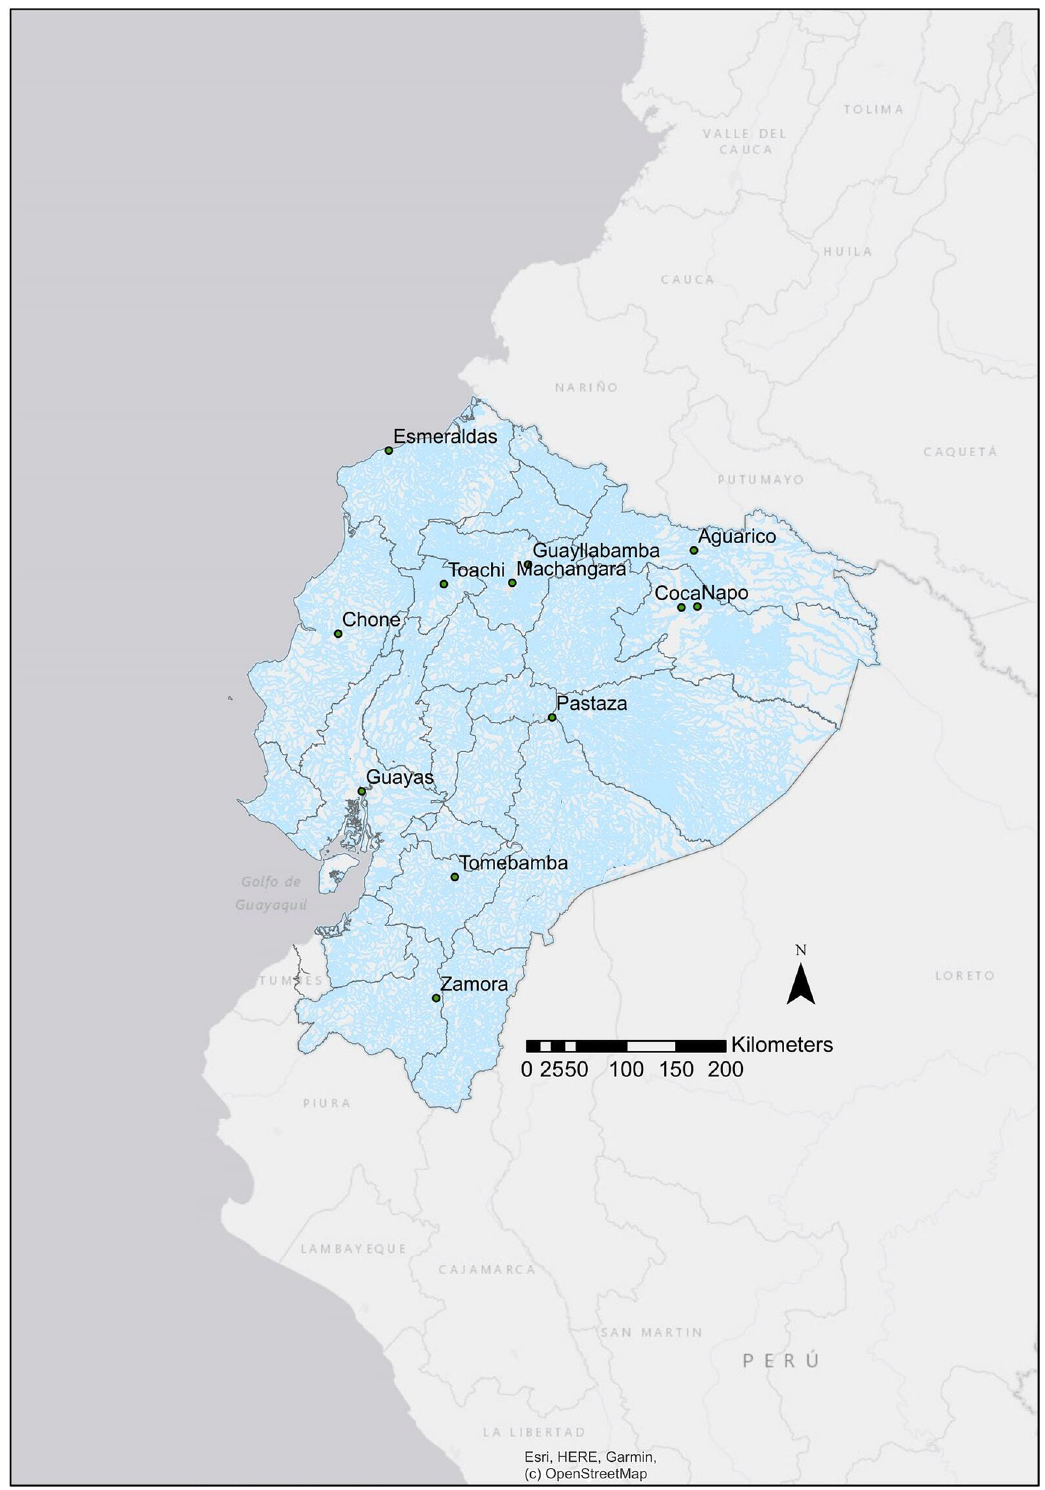
Figure 6. Illustration of the collection sampling points selected in this study for the microbial and chemical evaluation of the main Ecuadorian rivers. Legend: The map of Ecuador with the collection sampling points was created through ArcGIS Desktop software (version 10.8, available online: https:// deskt op. arcgis. com/